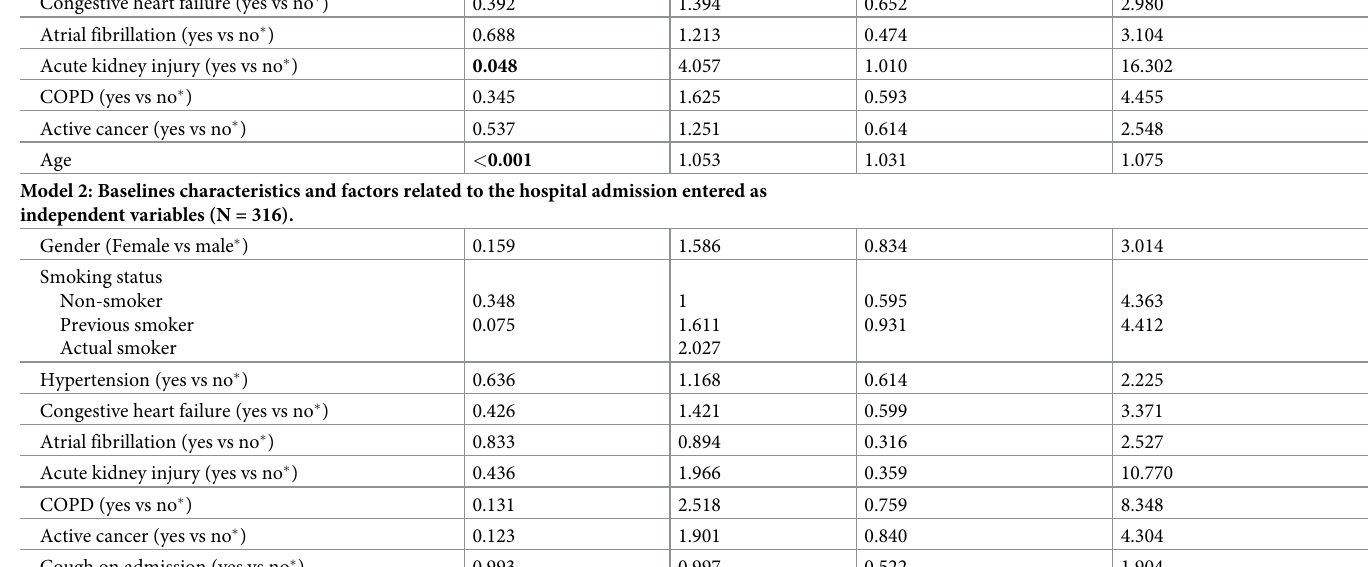
Enoxaparin intake (yes vs no �